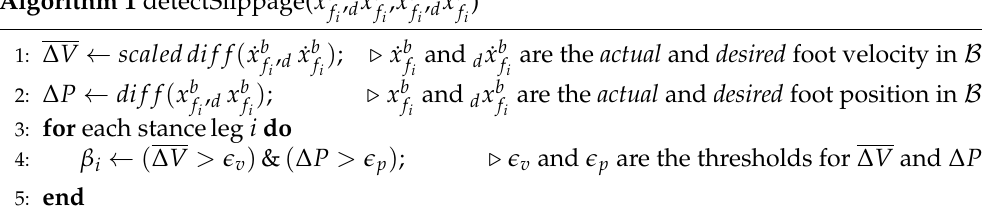
Algorithm 1 detectSlippage( ˙ x b